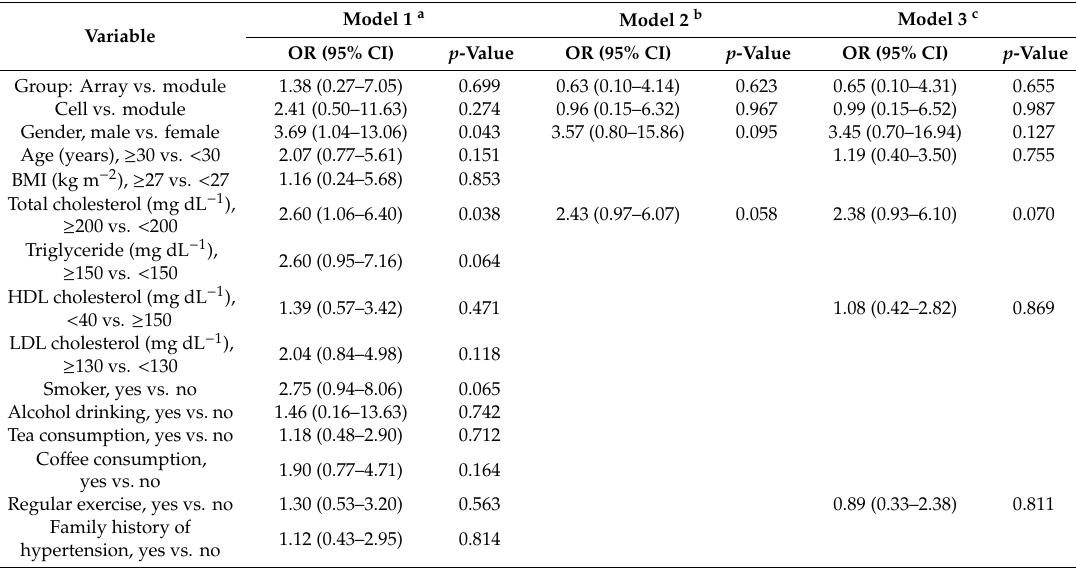
Table 5. Associations between groups and the risk of hypertension using logistic regression models.